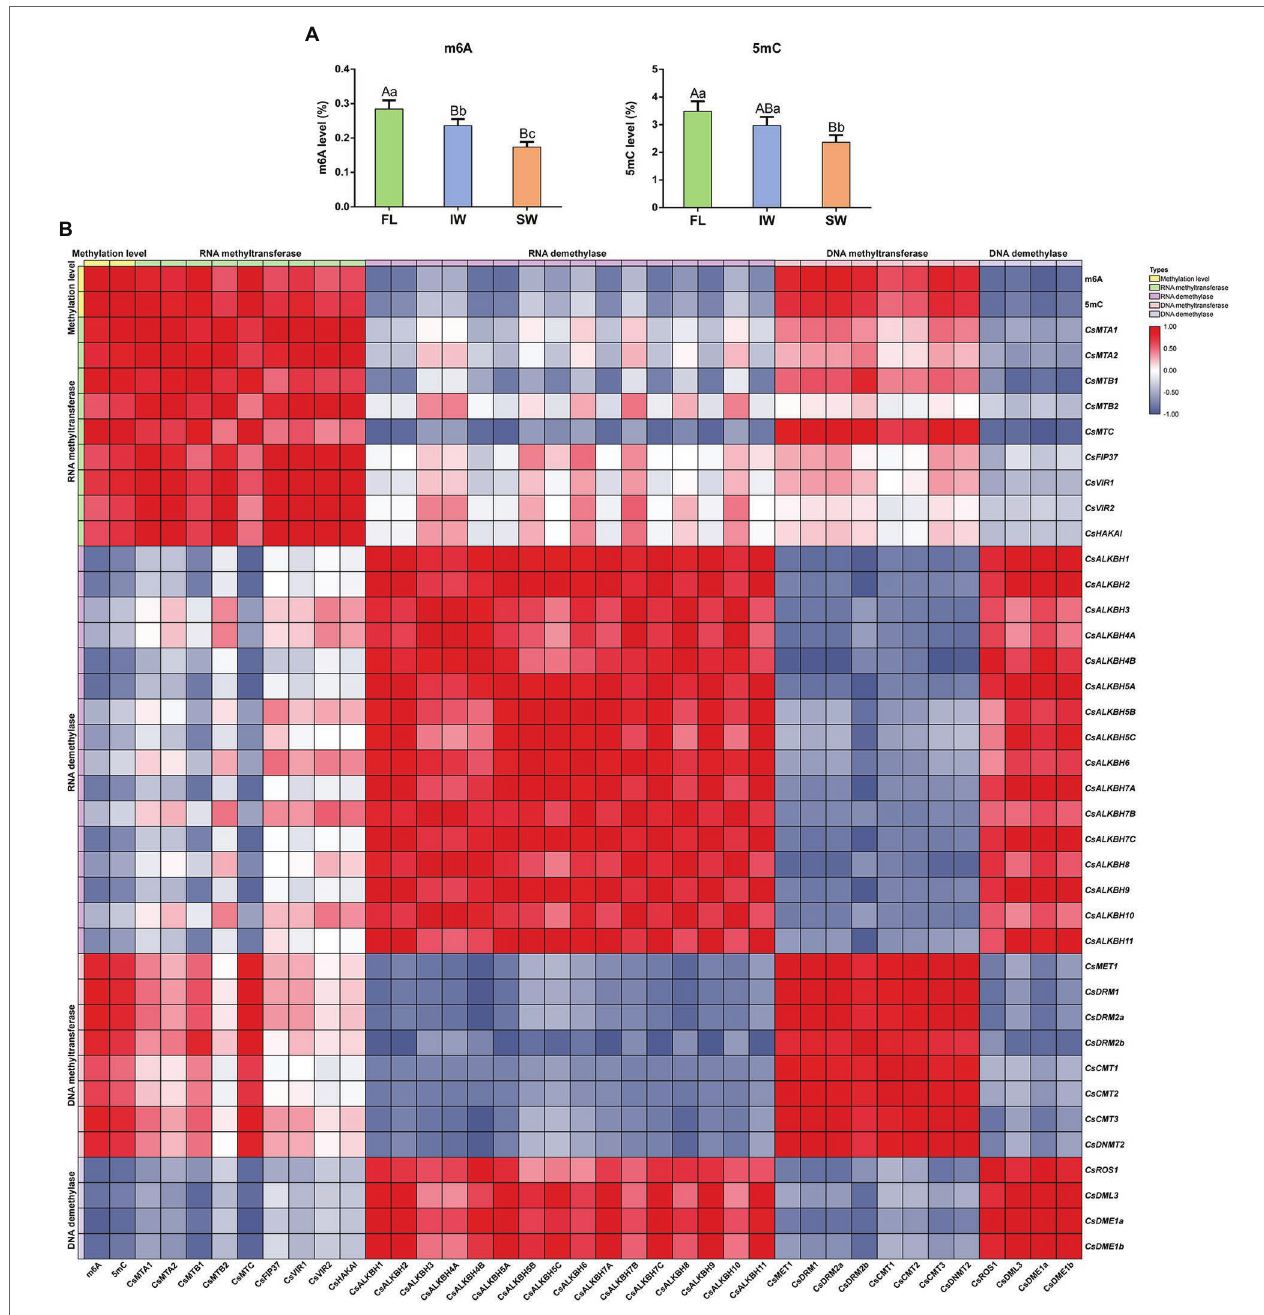
FIGURE 11 | Dynamics of RNA methylation (m6A) and DNA methylation (5mC) in fresh leaves (FL), indoor-withered leaves (IW), and solar-withered leaves (SW) and correlation analyses of m6A regulatory genes, 5mC regulatory genes, m6A levels, and 5mC levels. (A) The levels of m6A and 5mC. (B) Correlation analyses of m6A level, 5mC level, and corresponding regulatory gene expression. Data are presented as mean ± SD. Lowercase letter indicates significant difference ( p < 0.05); uppercase letter indicates highly significant difference ( p < 0.01). To comprehensively ascertain whether there may exist the interplay between RNA and DNA methylation during tea-withering, the correlation between methylation level and corresponding regulatory gene expression was evaluated by Pearson’s correlation coefficient. Pearson’s correlation coefficient was determined by SPSS 25 software. A correlation coefficient greater than 0 indicates a positive correlation, while a correlation coefficient less than 0 indicates a negative